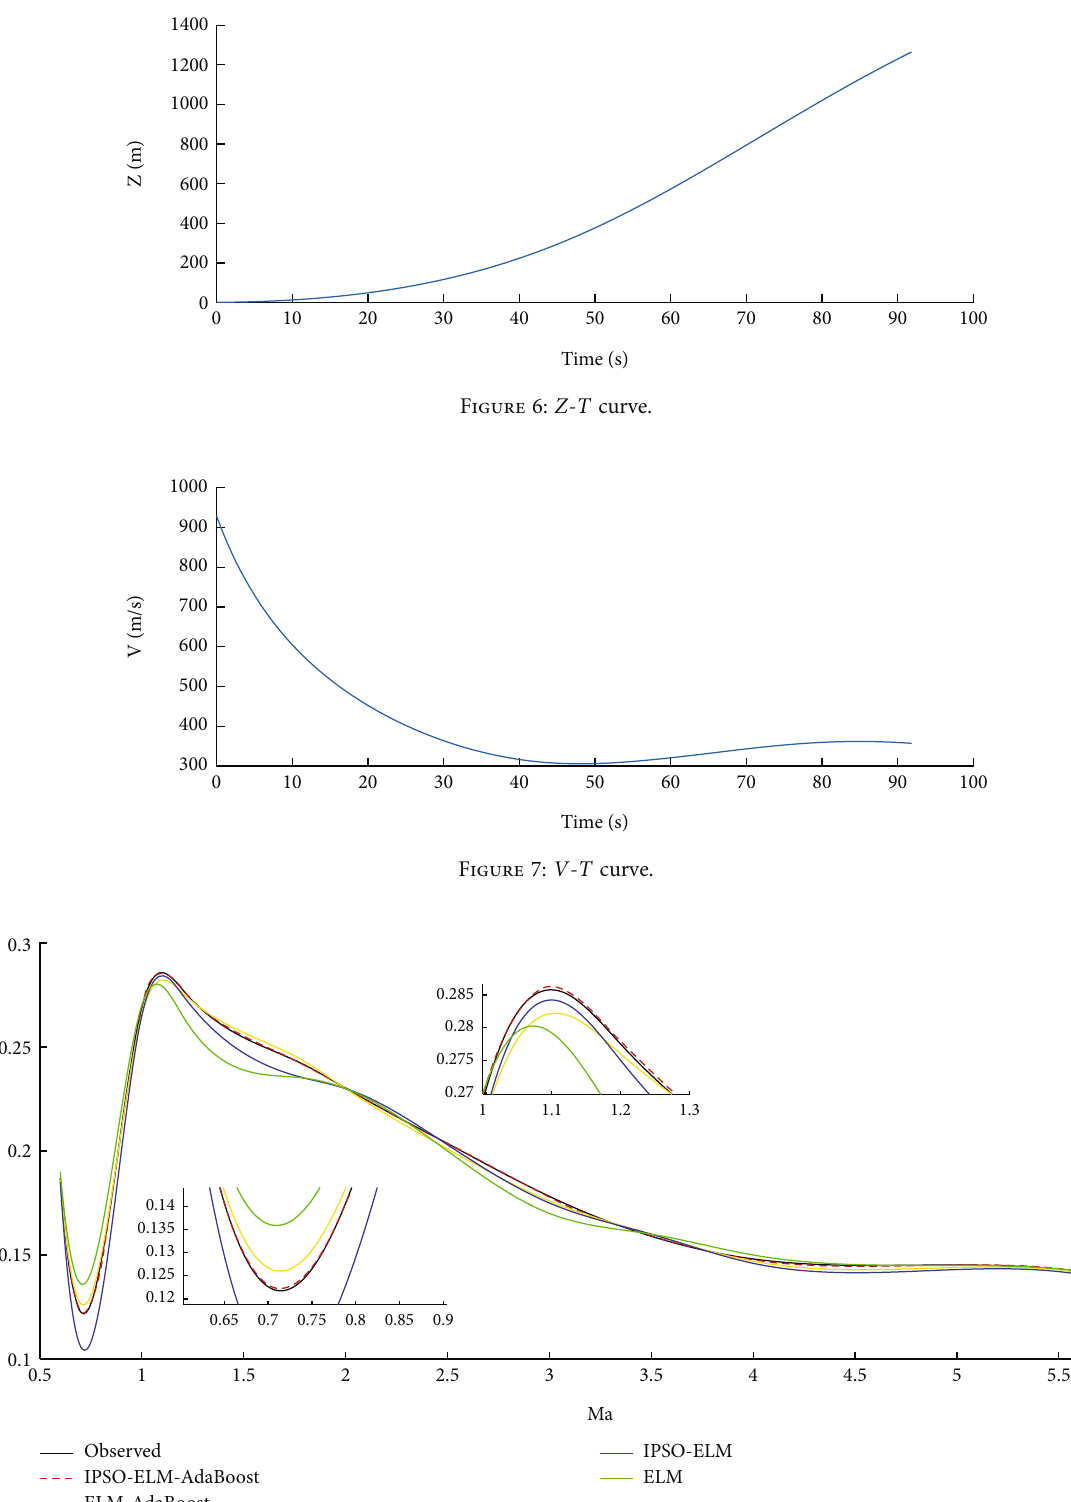
Figure 8: Identi fi cation results of c